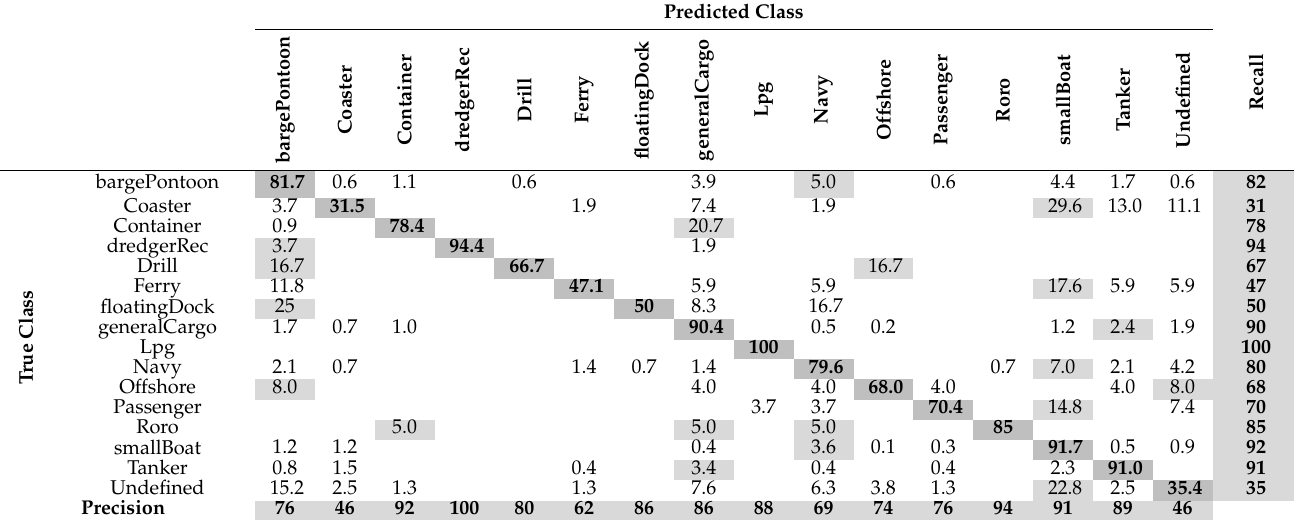
Table 9. The confusion matrix of the recognition stage (values in percentage). Predicted Class